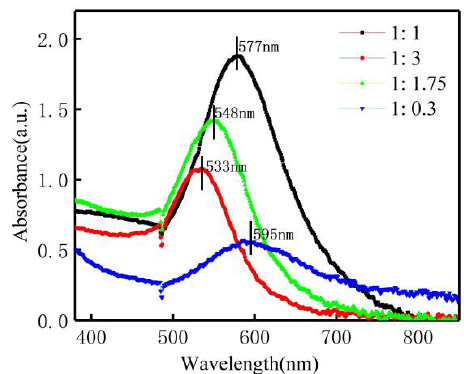
Figure 5. UV–Vis absorption spectra of AuNP for di ff erent HAuCl 4 / sodium citrate ratios: ( a ) 1:1, ( b ) 1:3,